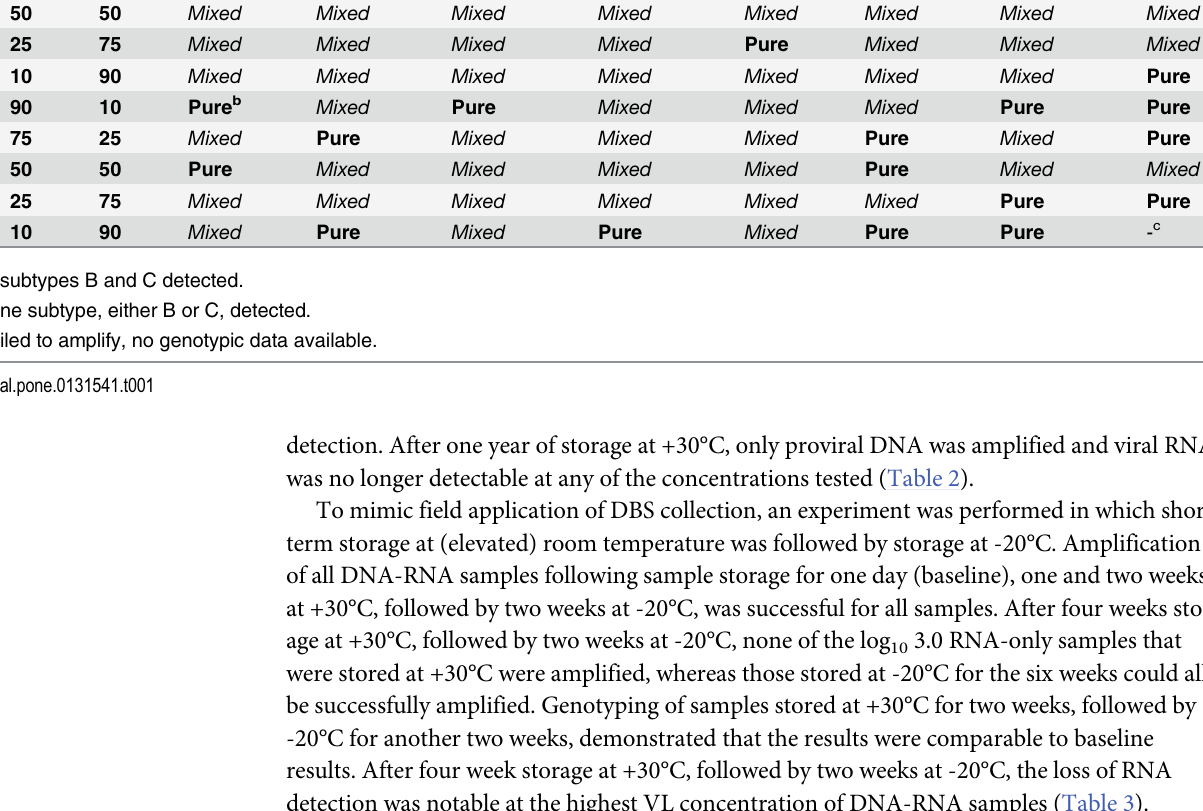
Table 2. Nucleic acid stability of viral RNA and proviral DNA in dried blood spot samples stored at -20°C or +30°C for six different time points.